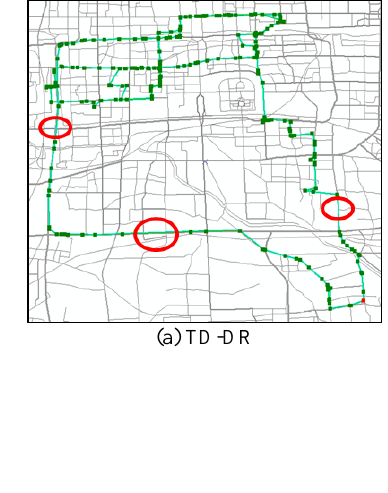
Figure 3. Experimental trajectory data and road networks